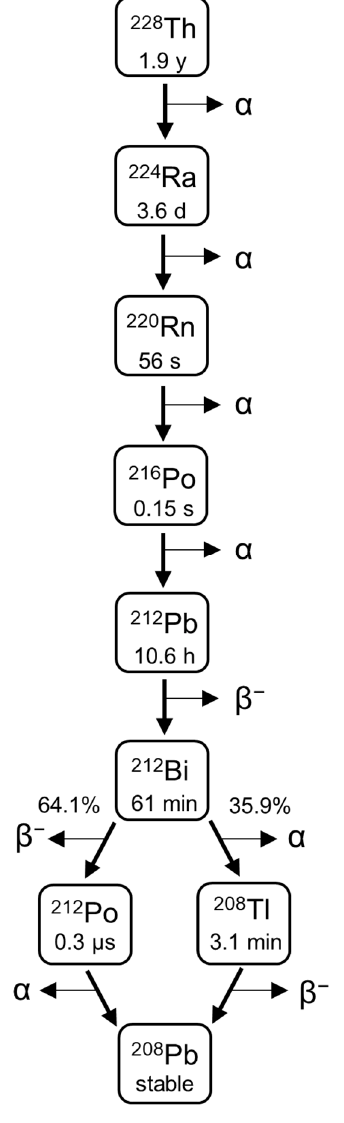
Figure 1. Decay chain of 224 Ra from parent 228 Th.